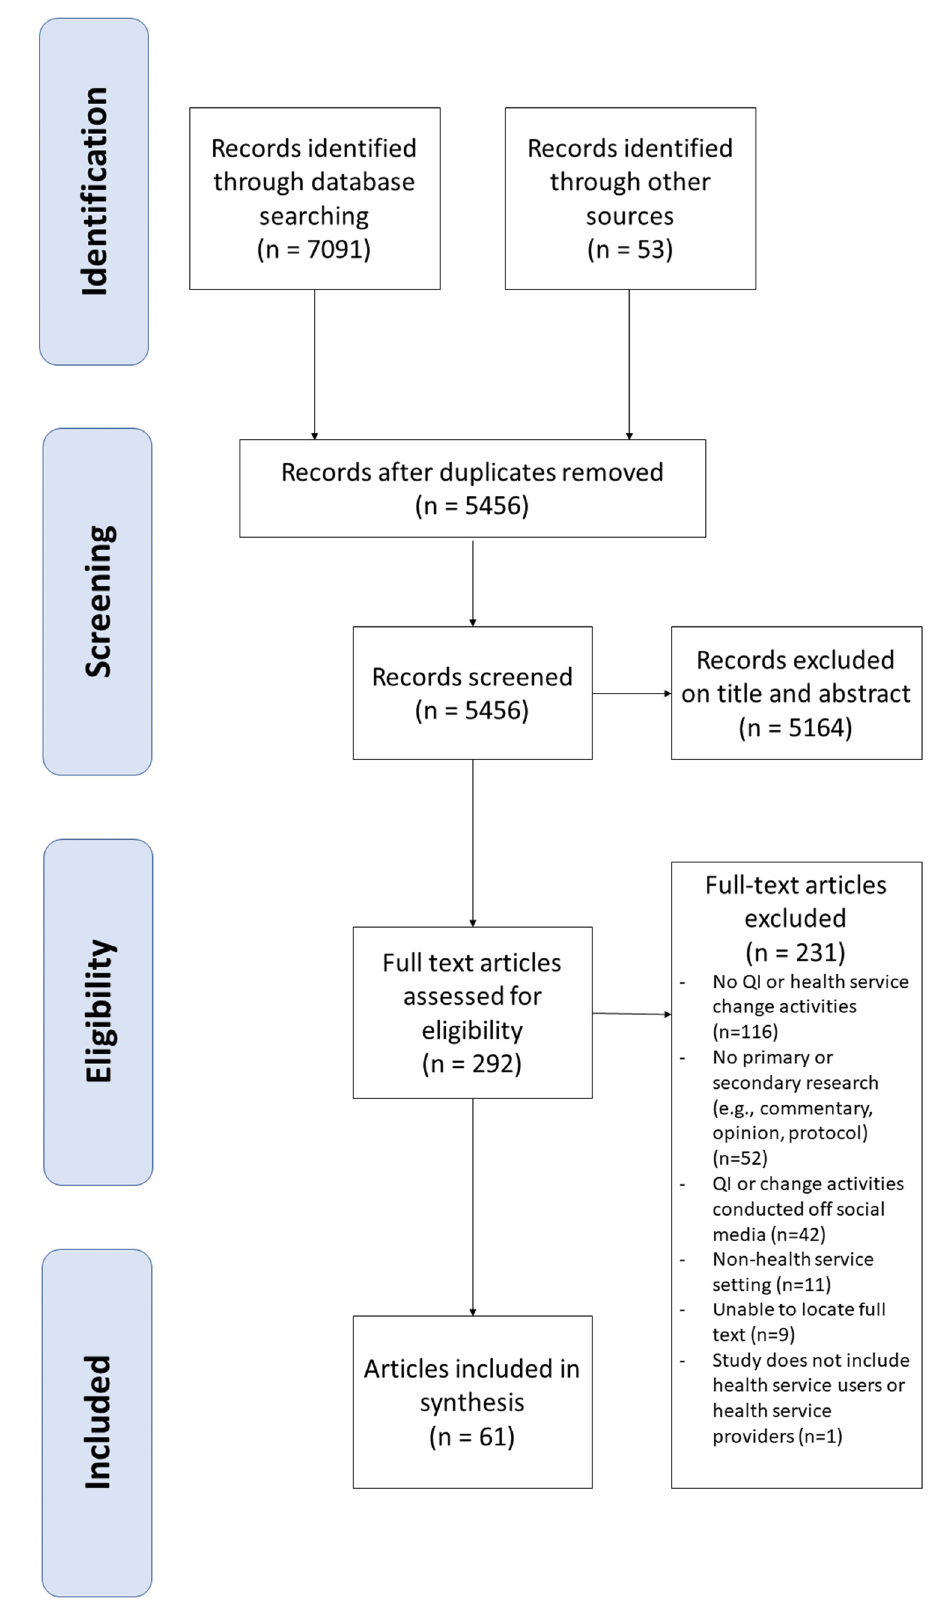
Figure 1. PRISMA Flow diagram. Source from [36].